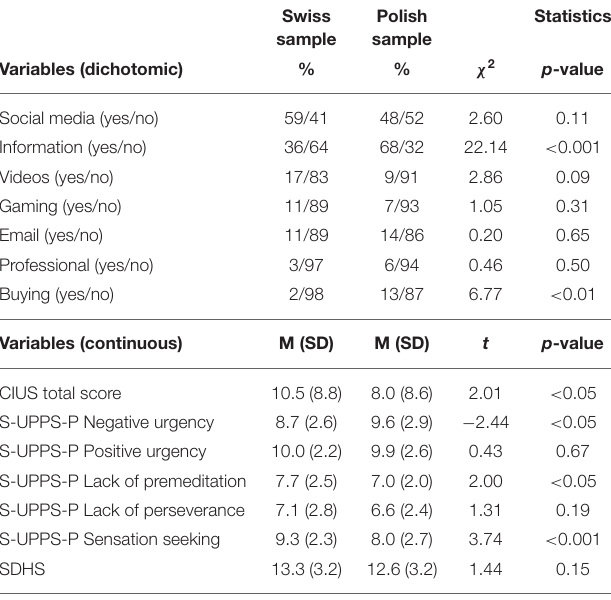
TABLE 2 | Group comparisons on type of online activities, CIUS, S-UPPS-P, SDHS scores.